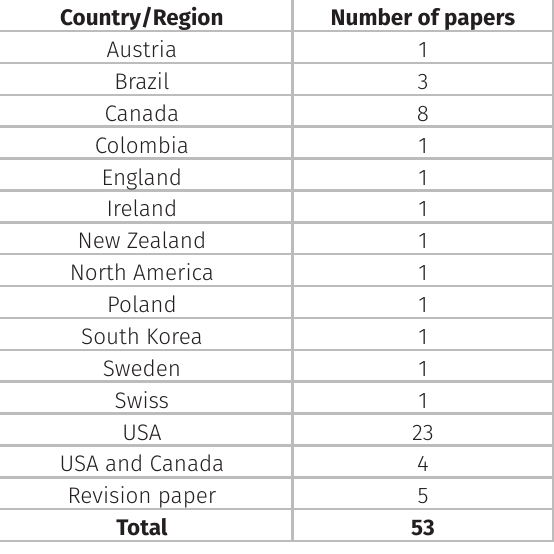
Table I. Geographic distribution of published studies on bird-window collisions.